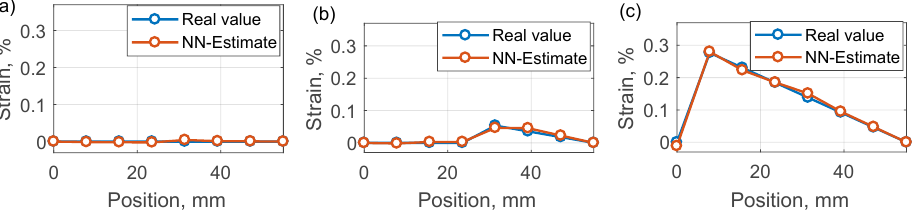
Figure 5. Results of the ANN model validation in bending test with no load and 40mm possible bending length (a) , a weight of 78g and 25mm bending length (b) , and a weight of 198g and 51mm bending length (c) . Table 1. Absolute and relative error between analytical results and the ANN model estimation for different validation dates Grid point Configuration Absolute error at grid point, ppm Relative error at grid